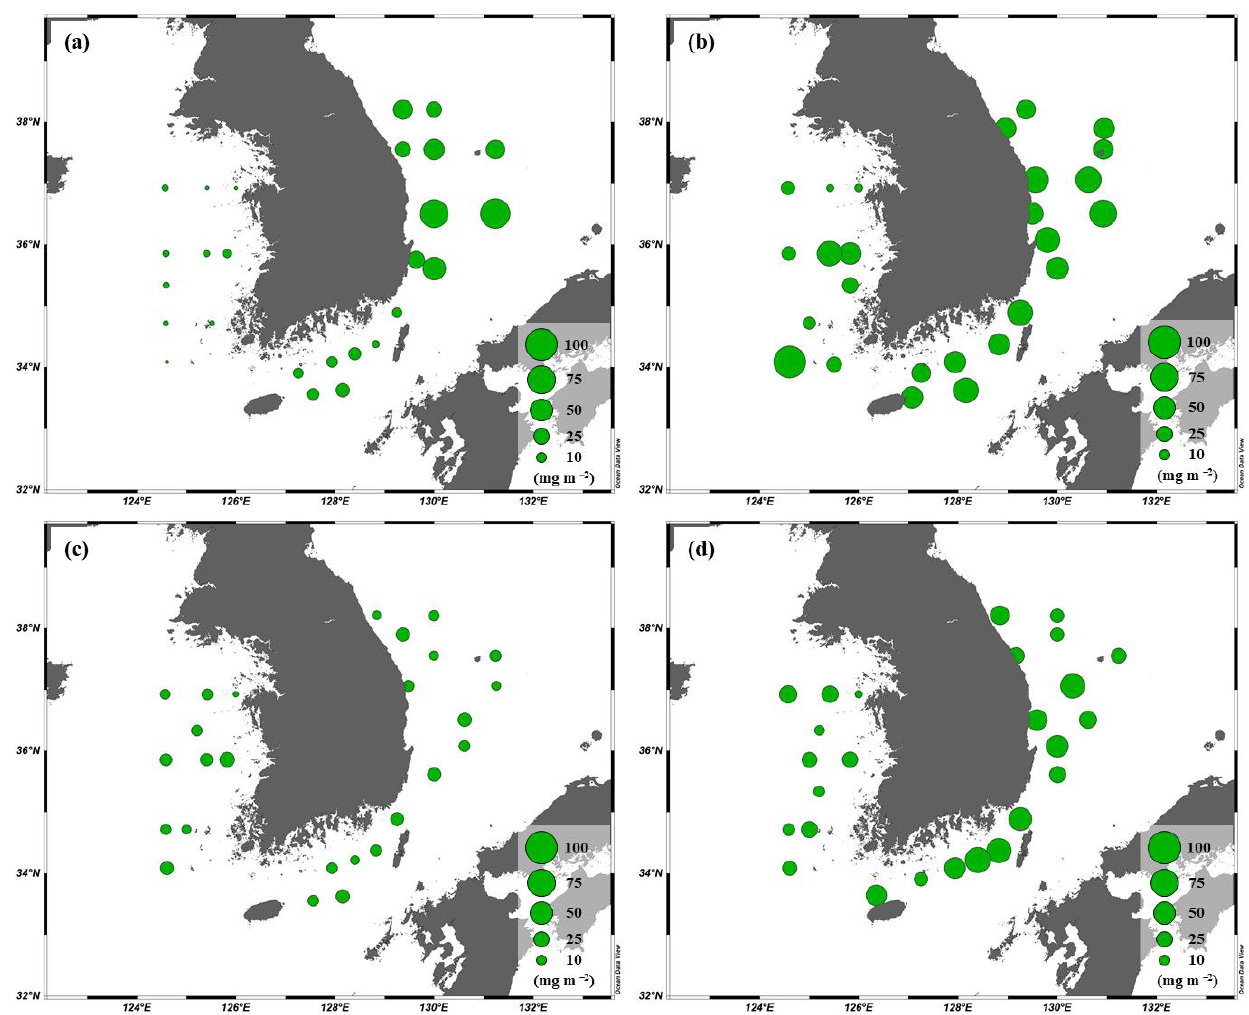
Figure 4. Spatial distributions of the chl- a concentrations integrated within the euphotic depth from 100 to 1% light depth in the YS, the SS, and the EJS during Feb. ( a ), Apr. ( b ), Aug. ( c ), and Oct. ( d ).